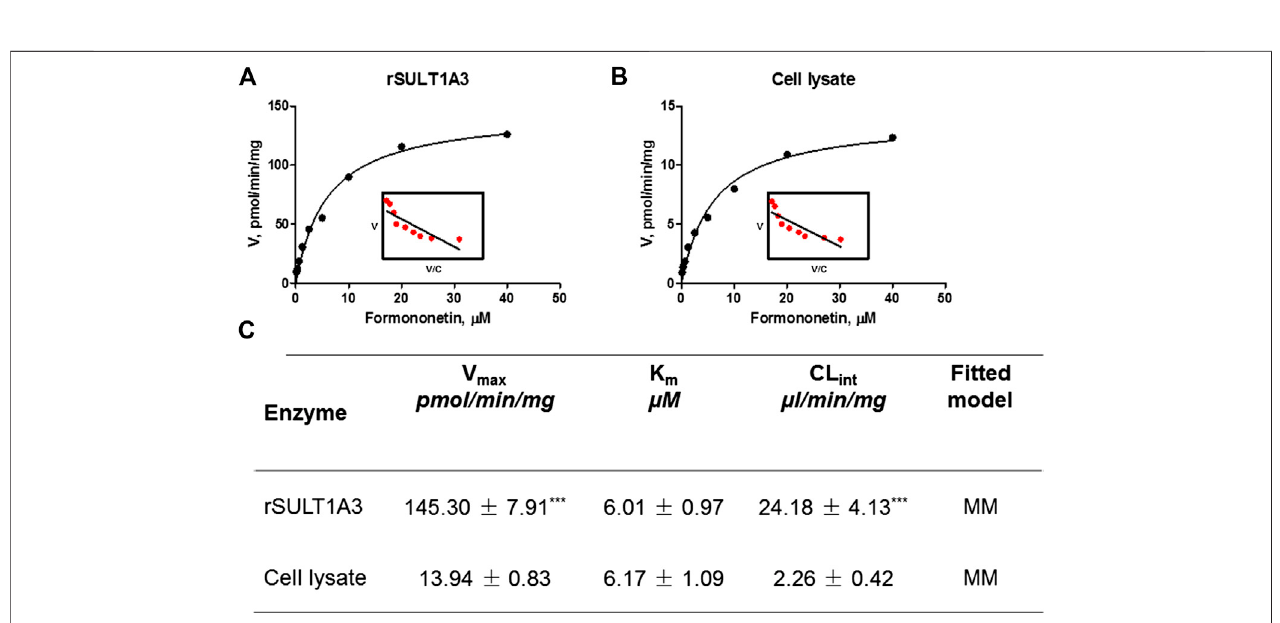
protein levels of SULT1A3 (r (cid:1) 0.728; p < 0.05) ( Figure 4B ).